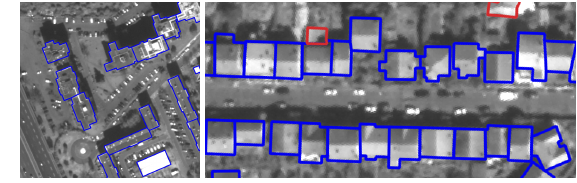
Figure 7. Apartment buildings and their instance annotation provided in the data set (indicated in blue). Red marked objects are not identifiable and excluded from evaluation.